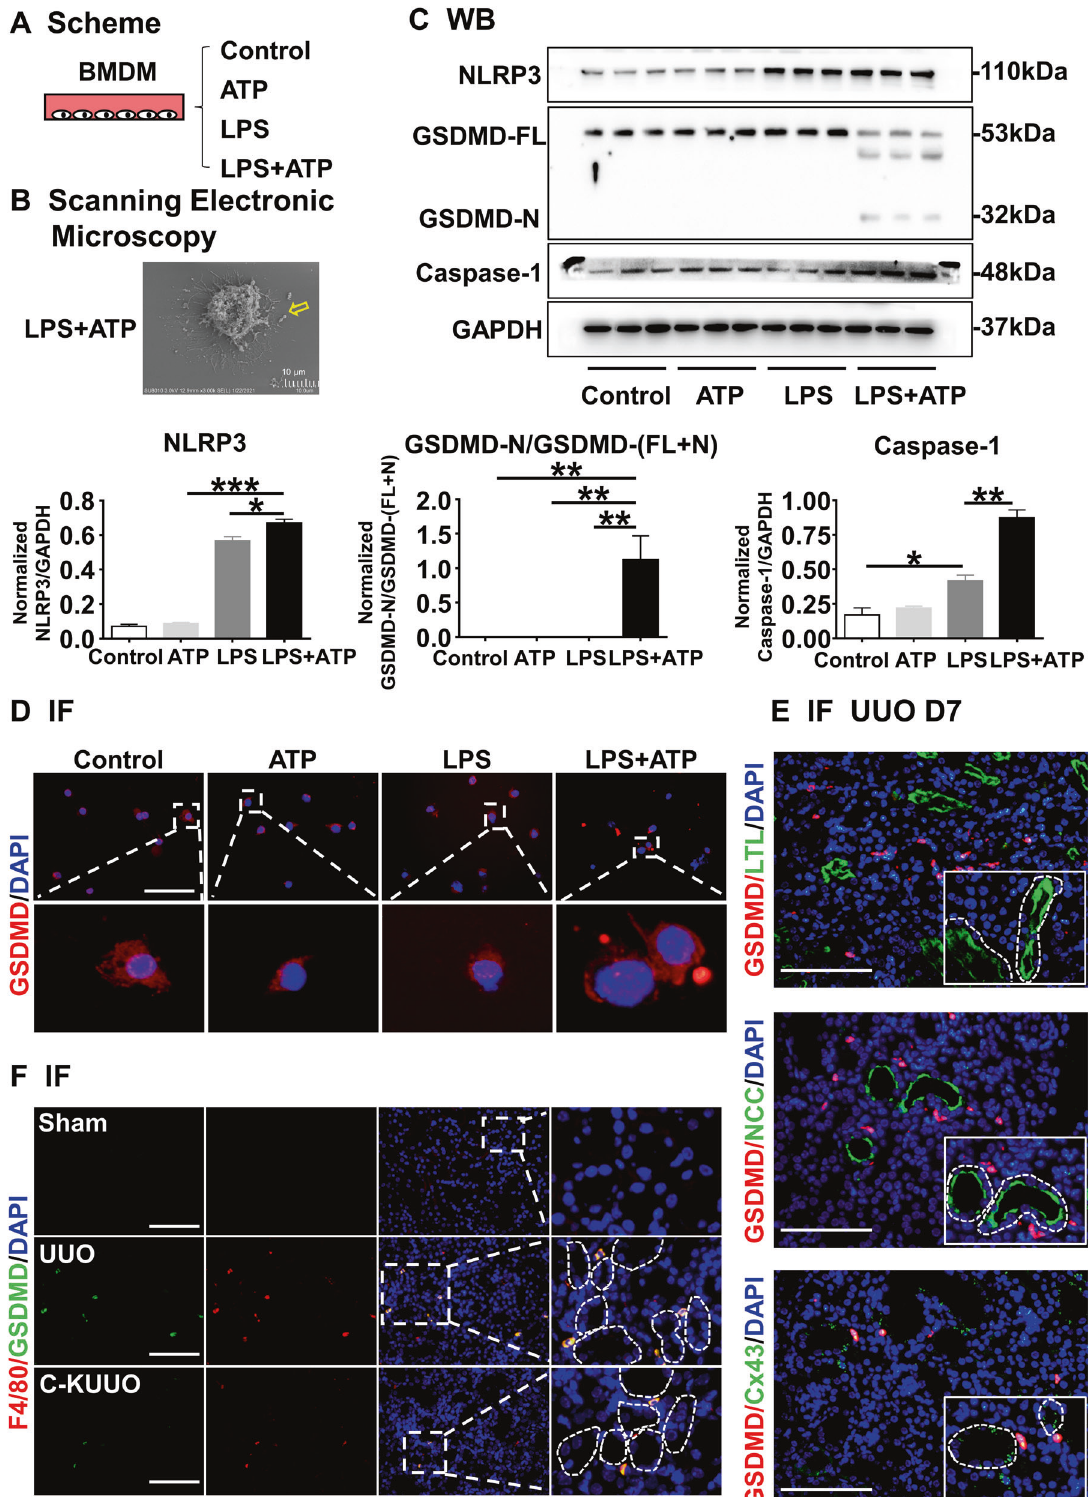
macrophage pyroptosis (Fig. 6E, F). WB analysis showed that NLRP3, caspase-1, ASC-1 and GSDMD-N were markedly reduced in the C-K UUO kidneys (Supplementary Fig. S5). Therefore, the out fl ow of ATP from TECs induced the activation of macrophage in fl ammasomes and triggered macrophage pyroptosis after